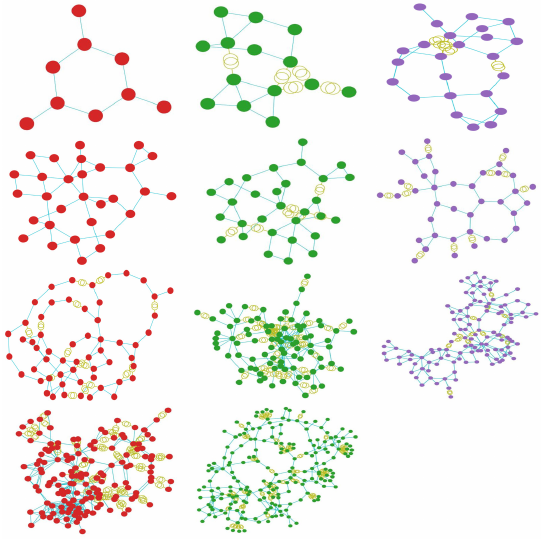
Figure 4. The test cases used in the simulation experiments. Starting from top left and moving horizontally, the images display the power system of cases: 9, 14, ieee 24, 30, ieee 30, 39, 57, 89, 118, 145 and 200.